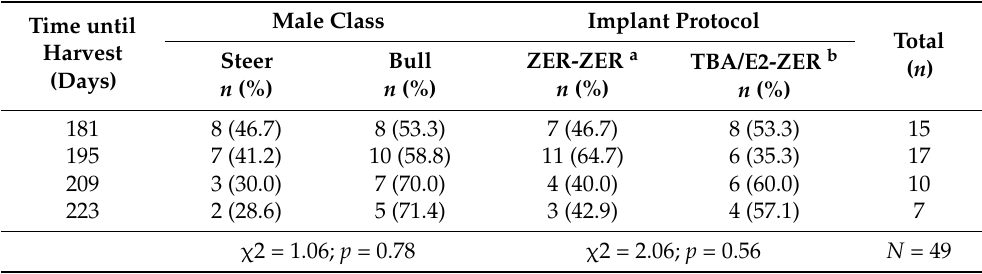
a ZER-ZER: corresponds to a dose (72 mg) of zeranol at d-0 followed by a second dose (72 mg) of zeranol at d-90; b TBA/E2-ZER: corresponds to a first dose containing 140 mg trenbolone acetate + 20 mg estradiol 17 β at d-0, followed by a second dose (72 mg) of zeranol at